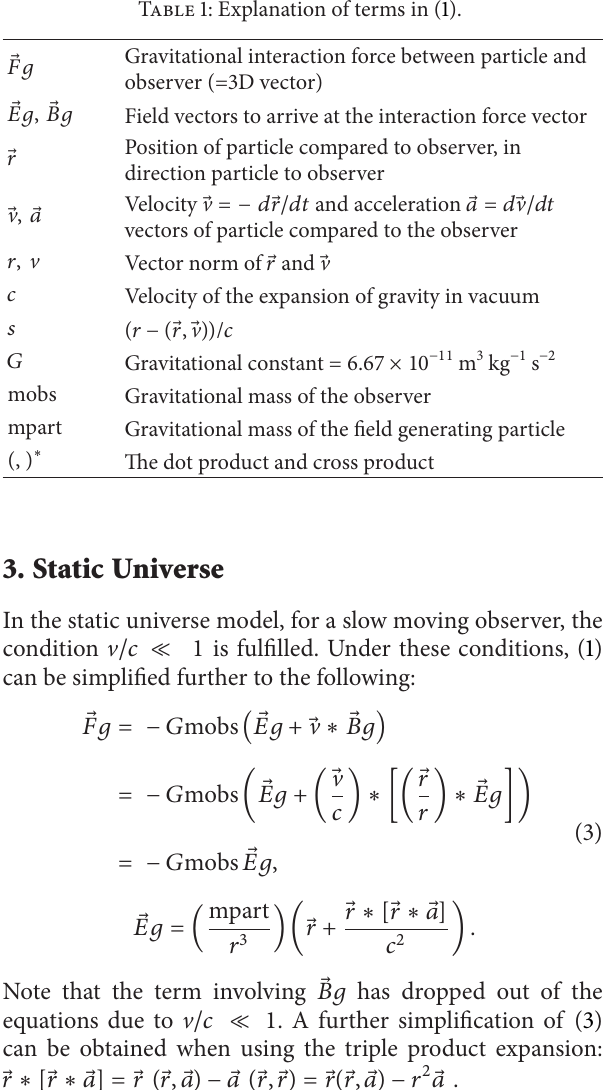
Table 1: Explanation of terms in